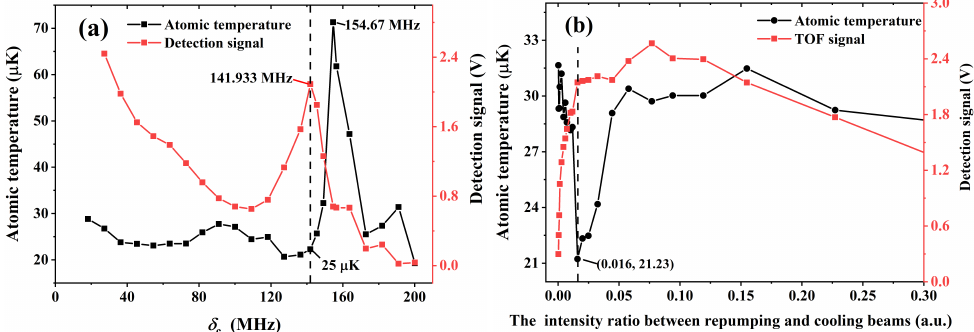
Figure 3. Effect of the laser beams on atoms during the stage of cooling: ( a ) relationship of frequency shift and atomic temperature; and ( b ) the ratio between repumping and cooling beams